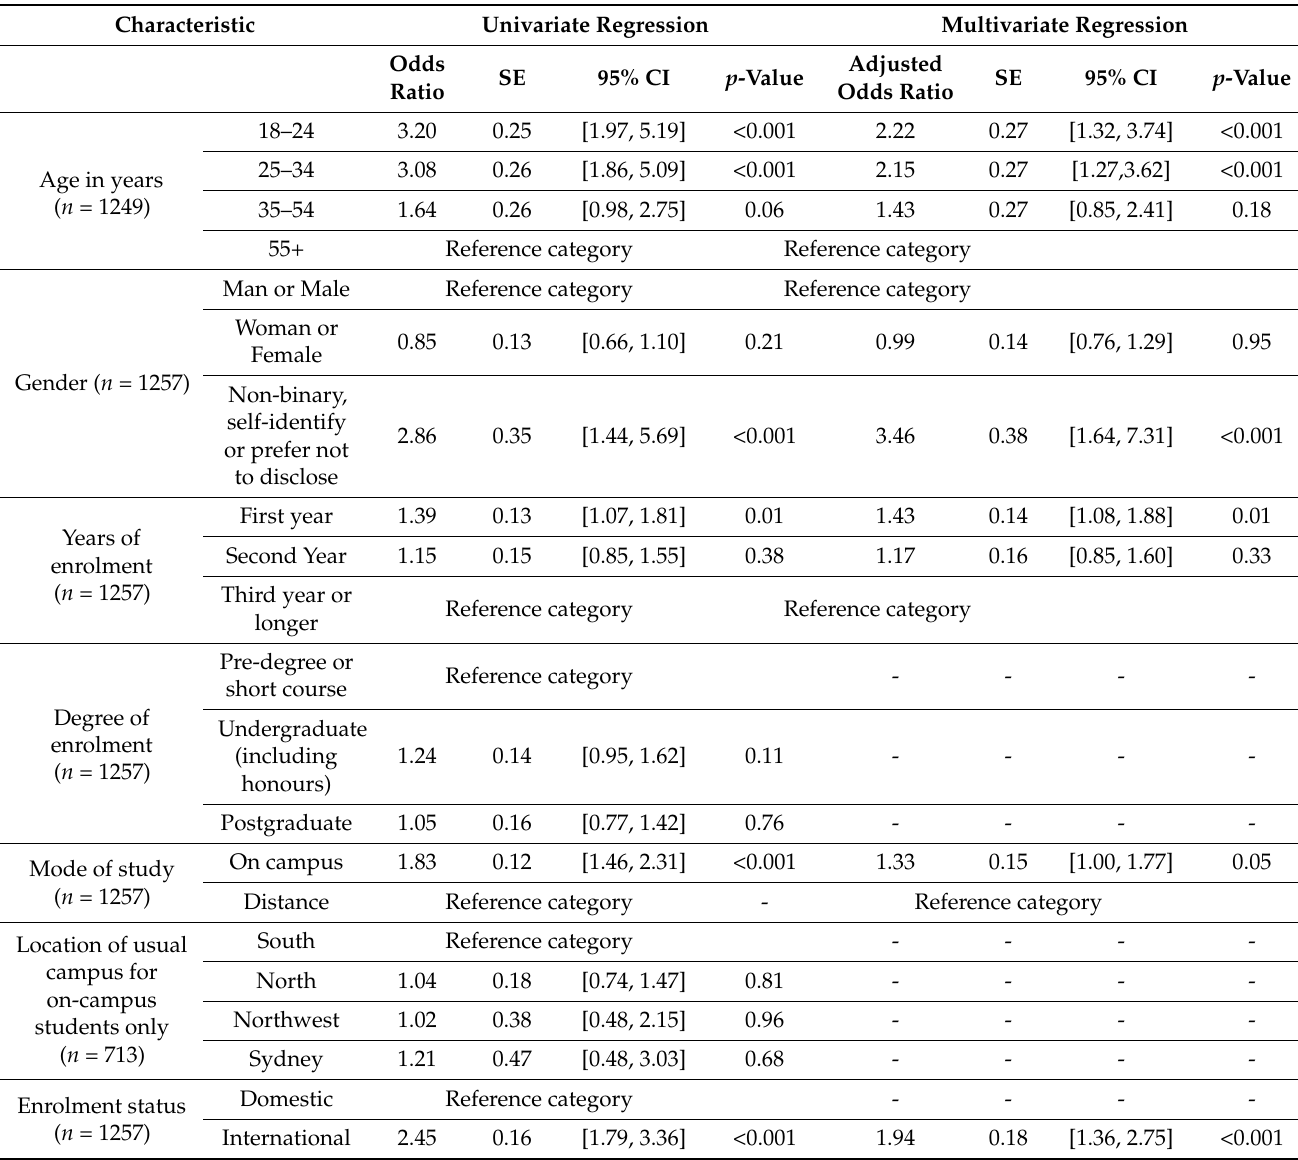
Table 2. Univariate and multivariate logistic regression results of food security with demographic characteristics in a sample of Australian university